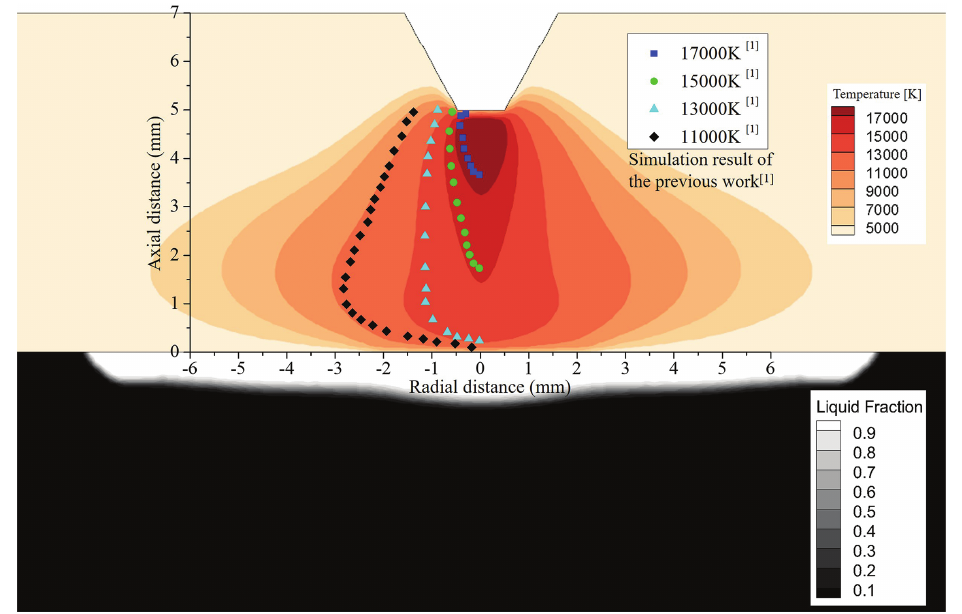
Figure 10. The calculated maximum velocity in weld pool is 49.8cm/s. The radius of weld pool reaches about 8mm. Though the predicted velocity and the weld pool shape are